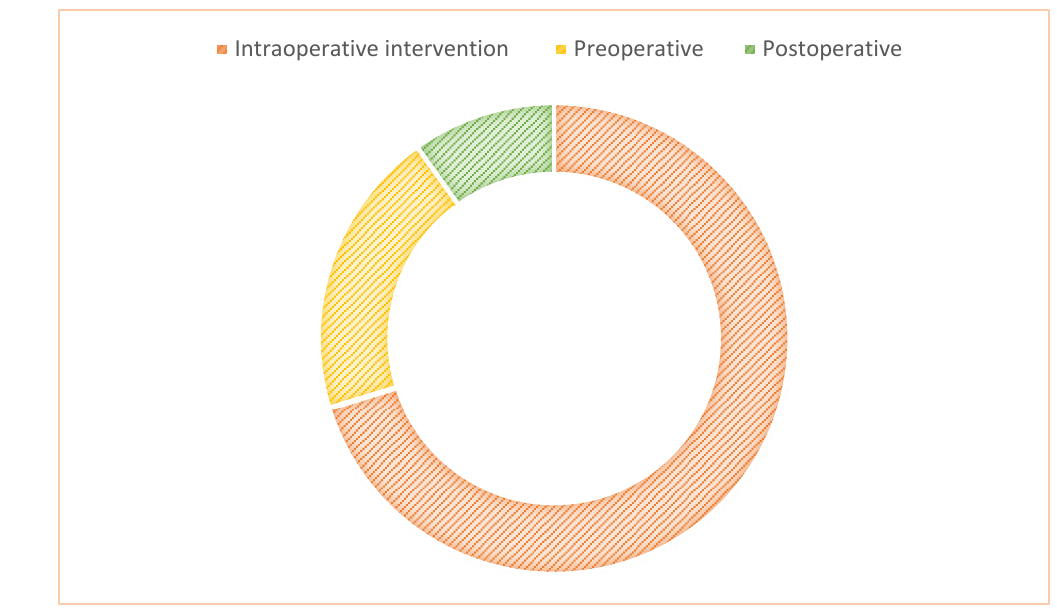
Figure 2. Use of Google Glass.